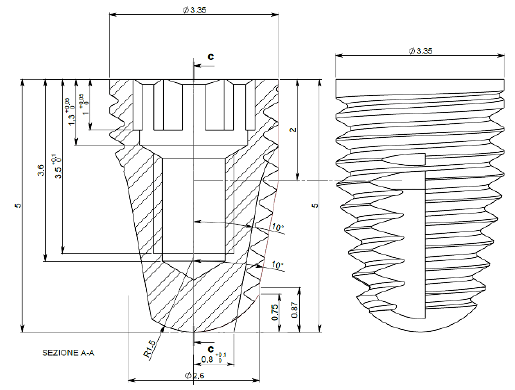
Figure 1. Implant technical dimensions.